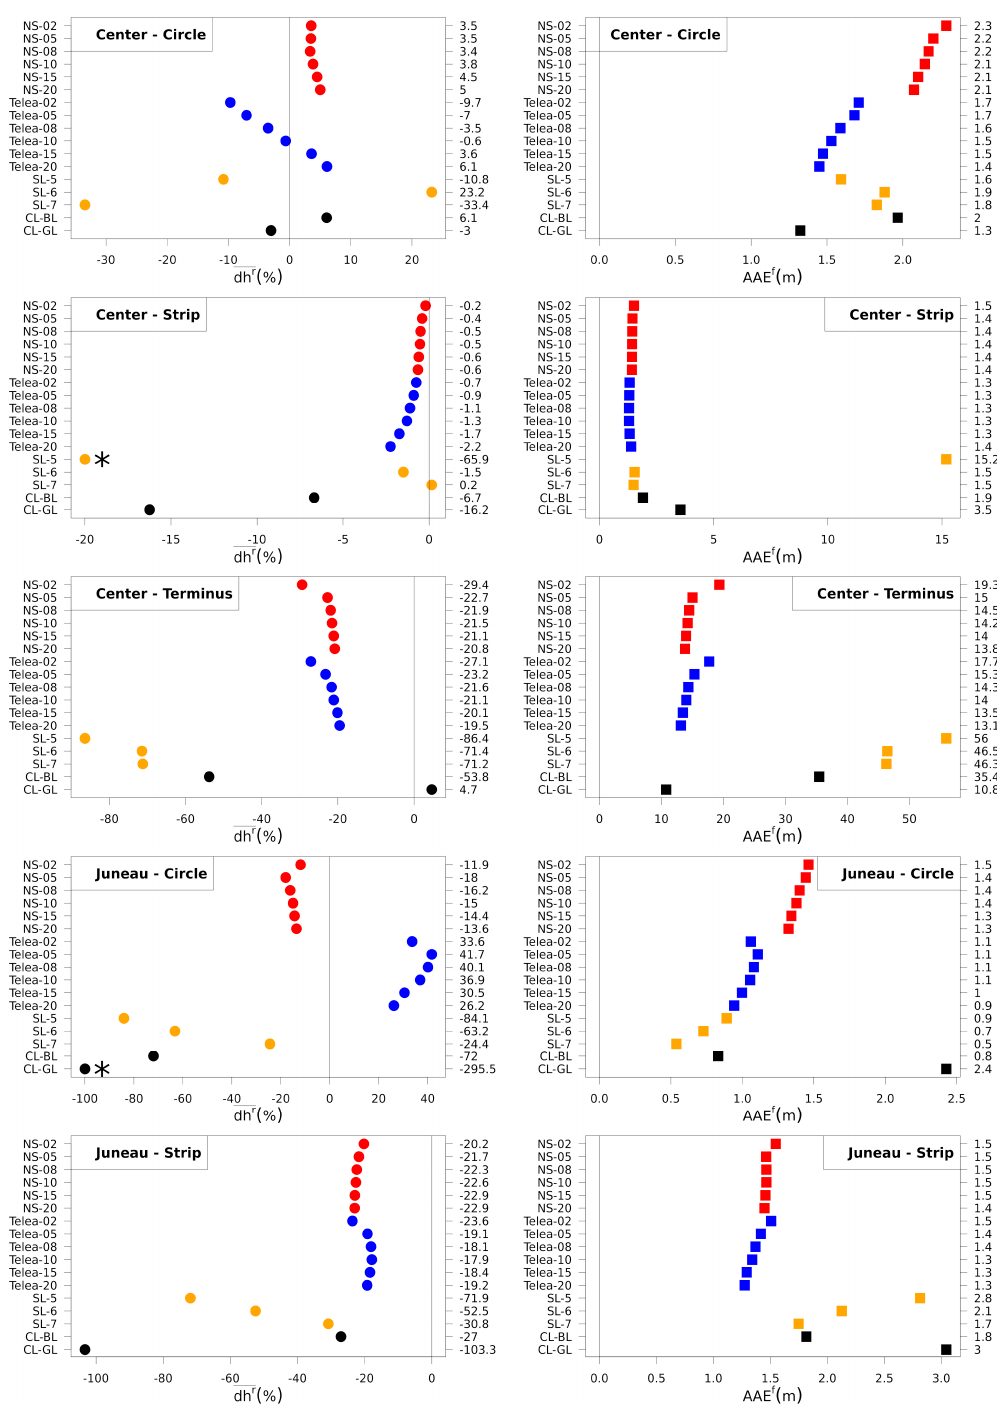
r Figure 5. Mean relative o ff set dh and absolute average error AAE f of the individual voids for the Figure 5. Mean relative offset (cid:1856)ℎ(cid:3364)(cid:3364)(cid:3364)(cid:3364) (cid:3045) and absolute average error (cid:1827)(cid:1827)(cid:1831) (cid:3033) of the individual voids for the Center and Juneau setups. * values out of Center and Juneau setups. * values out of bounds.